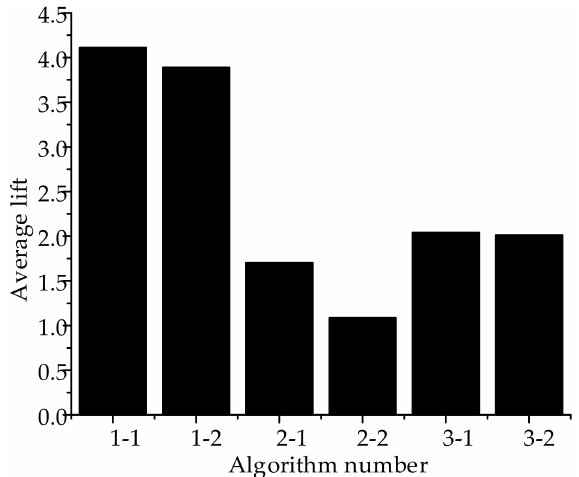
Figure 13. Comparison between AFWA-H-Mine and traditional algorithms of the first case.